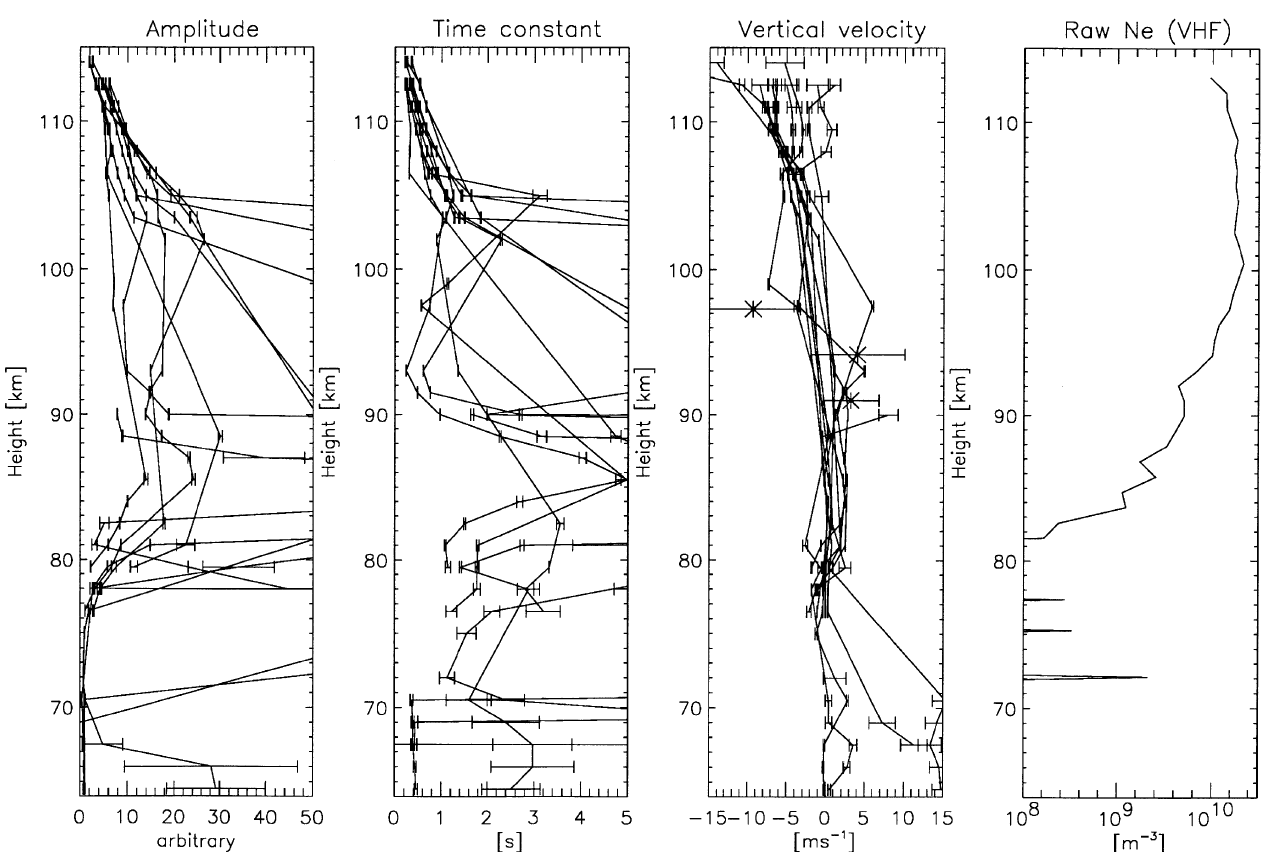
vertical velocities ( asterisks ) and electron density ( rightmost panel ); 18 November 1993, 1145 — 1150 UT